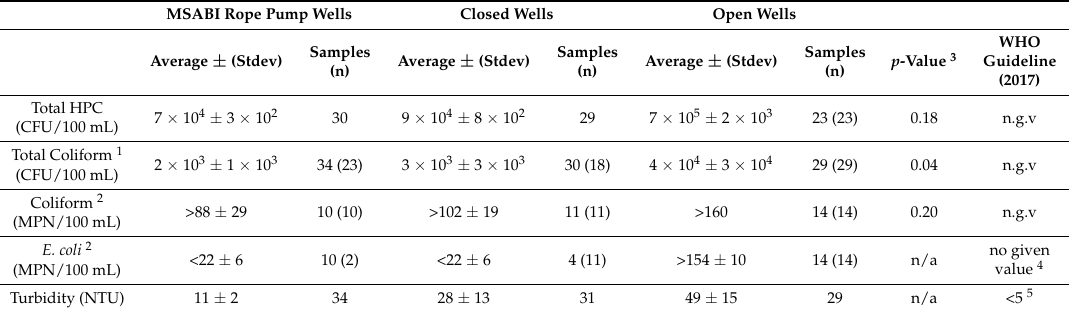
Table 1. Water microbial quality for Maji Safi kwa Afya Bora Ifakara (MSABI) rope pump, closed, and open